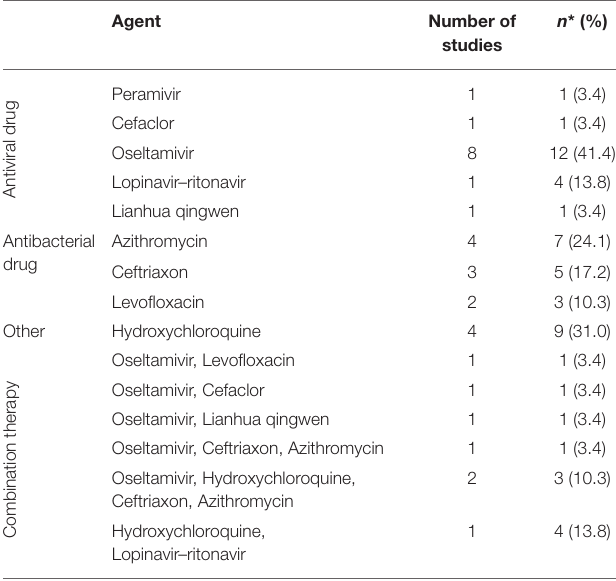
TABLE 7 | Agents used in the treatment of patients with COVID-19 and Influenza co-infection among a total of 29 evaluated patients. Agent Number of